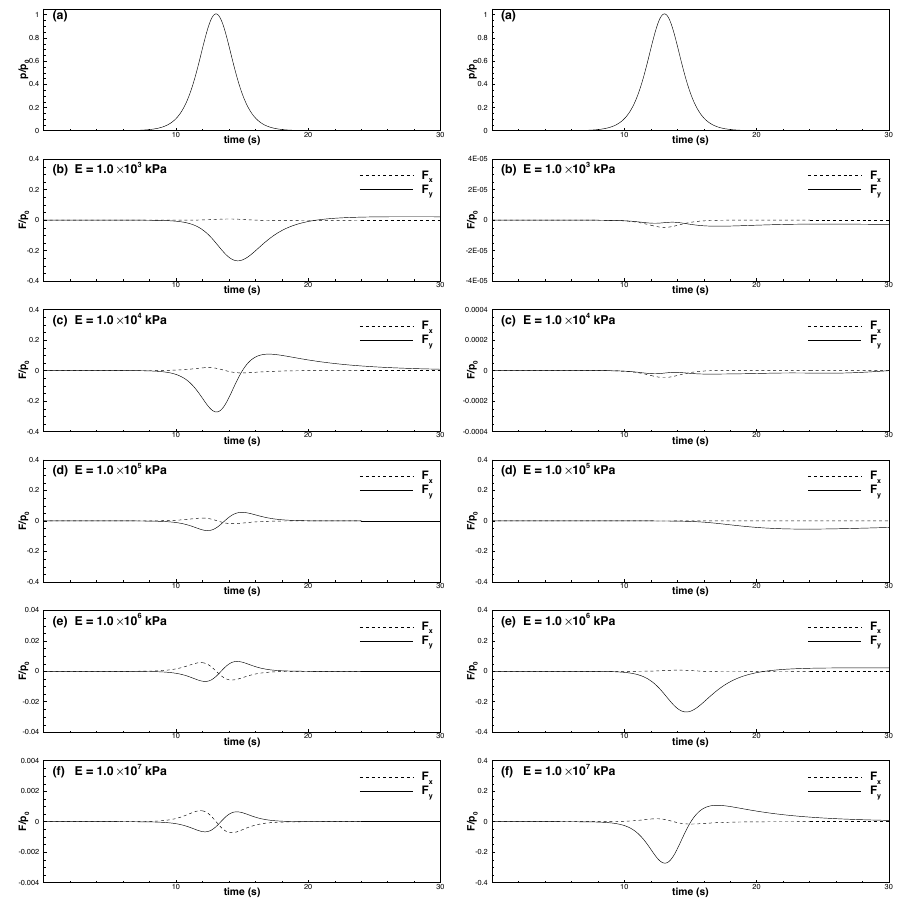
Figure 15. Time evolution of seepage force exerted on the pipeline at various E values and left : k = 1.0 × 10 − 3 m/s; right : k = 1.0 × 10 − 6 m/s. ( a ) Dynamic pressure at the seabed above the pipeline; ( b – f ) horizontal and vertical components of seepage force at different E